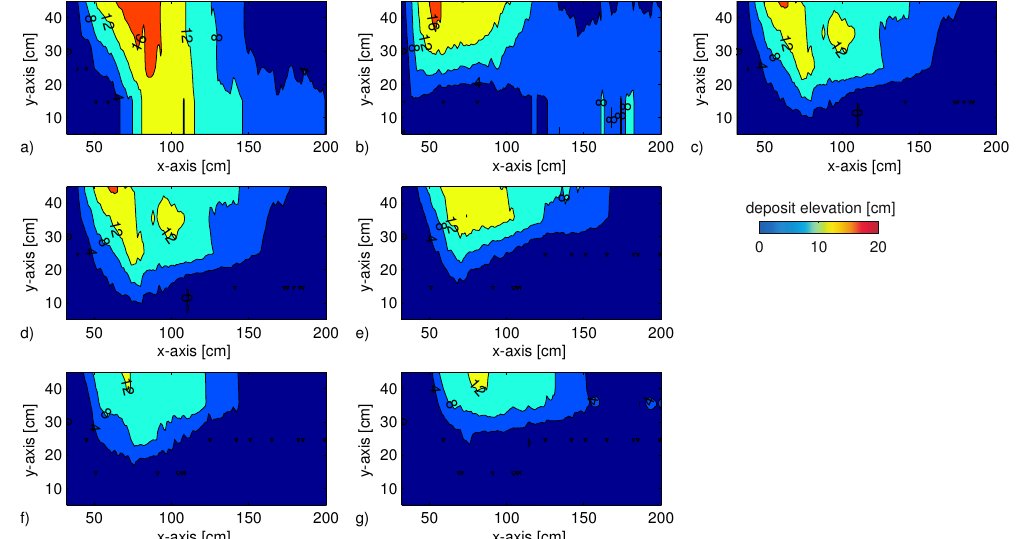
Figure 5. Debris deposit morphology acquired at the end of a given experiment. ( a – c ) Experiments carried out with the same confluence angle (90 ◦ ) and debris flow discharge (9 L/s), changing the water discharge. ( a ) 2.0 L/s, ( b ) 3 L/s, ( c ) 4.5 L/s. ( d,e ) Experiments with the same water discharge (4.5 L/s) and debris flow discharge (9 L/s), changing the confluence angle. ( d ) 90 ◦ , ( e ) 60 ◦ . ( f , g ) Experiments with the same water discharge (4.5 L/s) and debris flow discharge (7 L/s), changing the confluence angle. ( f ) 90 ◦ , ( g ) 60 ◦